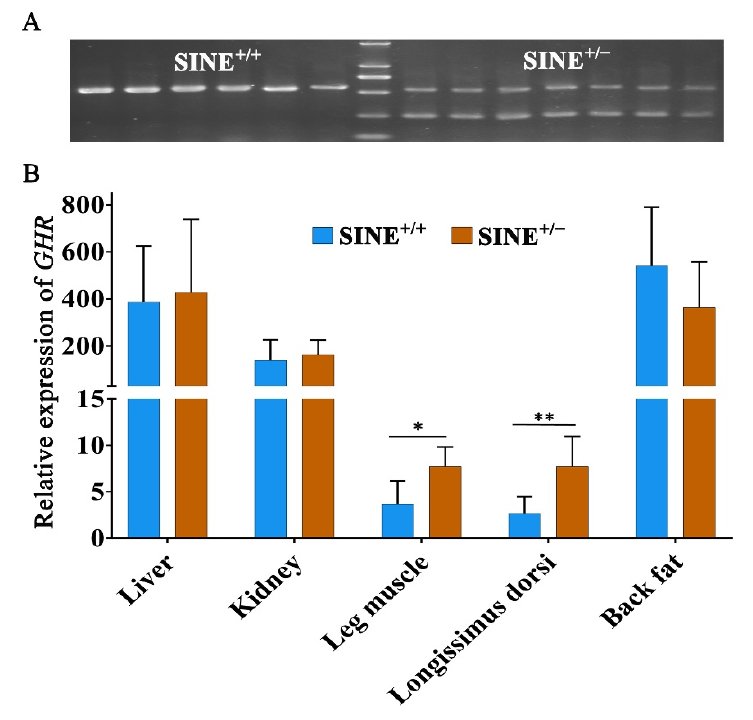
Figure 3. Association of SINE insertion genotype with the expression of GHR in tissues of 30-day old piglets. ( A ) Genotype result for 13 Sujiang individuals. ( B ) RT-qPCR results for GHR expression. * showed p < 0.05; ** showed p < 0.01.